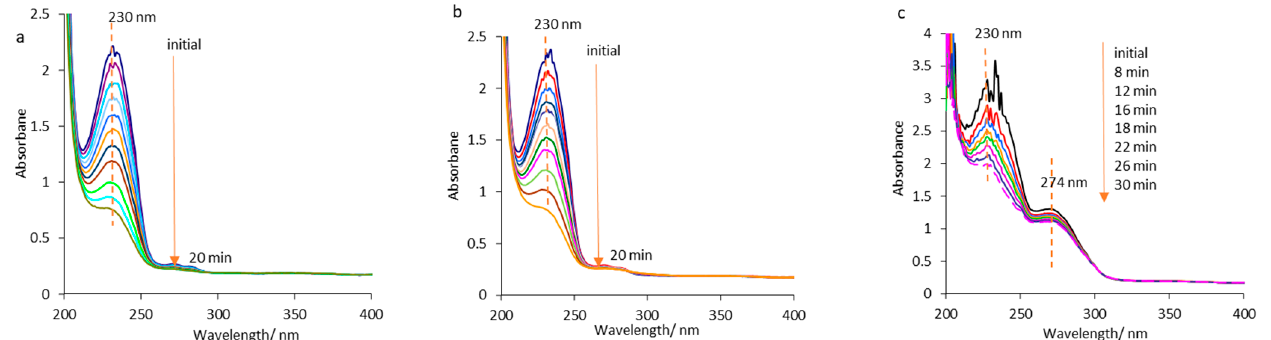
Figure 3. Paclitaxel UV-Vis spectra recorded during electrolysis at a constant current density of 50 mA cm ⁻ 2 : ( a ) in aqueous HCl solution (PTX_HCl); ( b ) in supporting electrolyte, in the absence of essential oil (PTX_SE); ( c ) in supporting electrolyte, in the presence of essential oil (PTX_ESO).